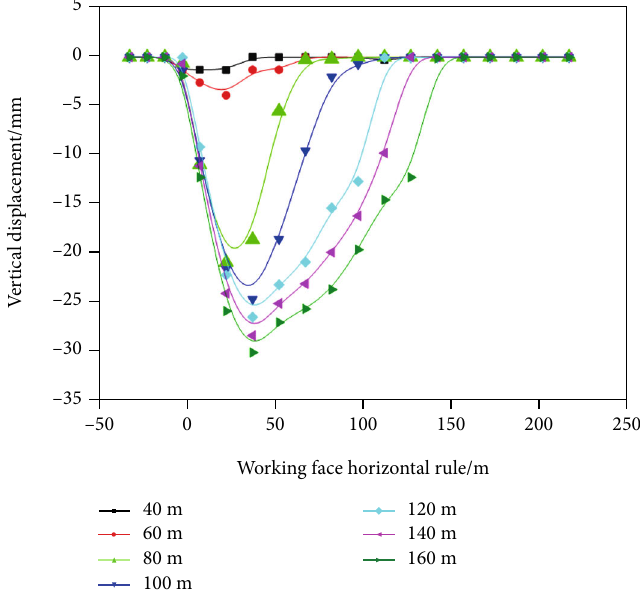
Figure 8: Dynamic subsidence curve of No. 2 line in the process of 1200m deep mining